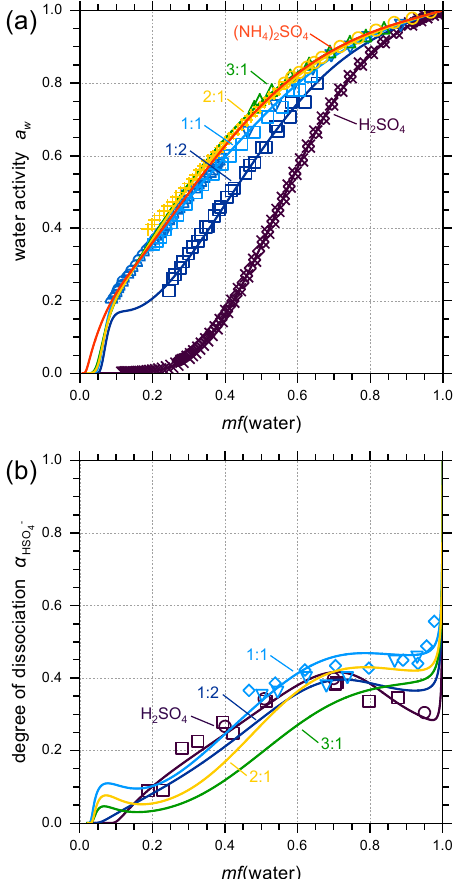
Fig. 10. Calculated and experimental water activities and degree of dissociation of the bisulfate ion in aqueous solutions of sulfuric acid and mixtures of ammonium sulfate and sulfuric acid (i.e., the (cid:10) H + + SO 2 − degree to which the second ionization stage, HSO − , 4 4 of sulfuric acid is established, see Zuend et al., 2008). The molar ratio of ( NH 4 ) 2 SO 4 : H 2 SO 4 is indicated for the different mixtures. (a) Calculated water activities (curves) and measured bulk and EDB water activity data (symbols) at room temperature; Robinson and Stokes (2002) ( ), Staples (1981) ( ), Kim et al. (1994) ( ), Tang and Munkelwitz (1977) ( ), Spann (1984) ( ), Tang and Munkel- witz (1994) ( ), Zuend et al. (2008) ( ), Zardini et al. (2008) ( ). Calculated a w of ( NH 4 ) 2 SO 4 is shown for comparison. (b) Corre- (Zuend sponding degrees of dissociation of the bisulfate ion, α HSO − 4 et al., 2008), as a function of the mass fraction of water. Mea- sured α of aqueous sulfuric acid by Knopf et al. (2003) ( ) HSO − 4 and Myhre et al. (2003) ( ), and of the 1 : 1 mixture by Young et al. (1959) ( ) and Dawson et al. (1986) ( ).